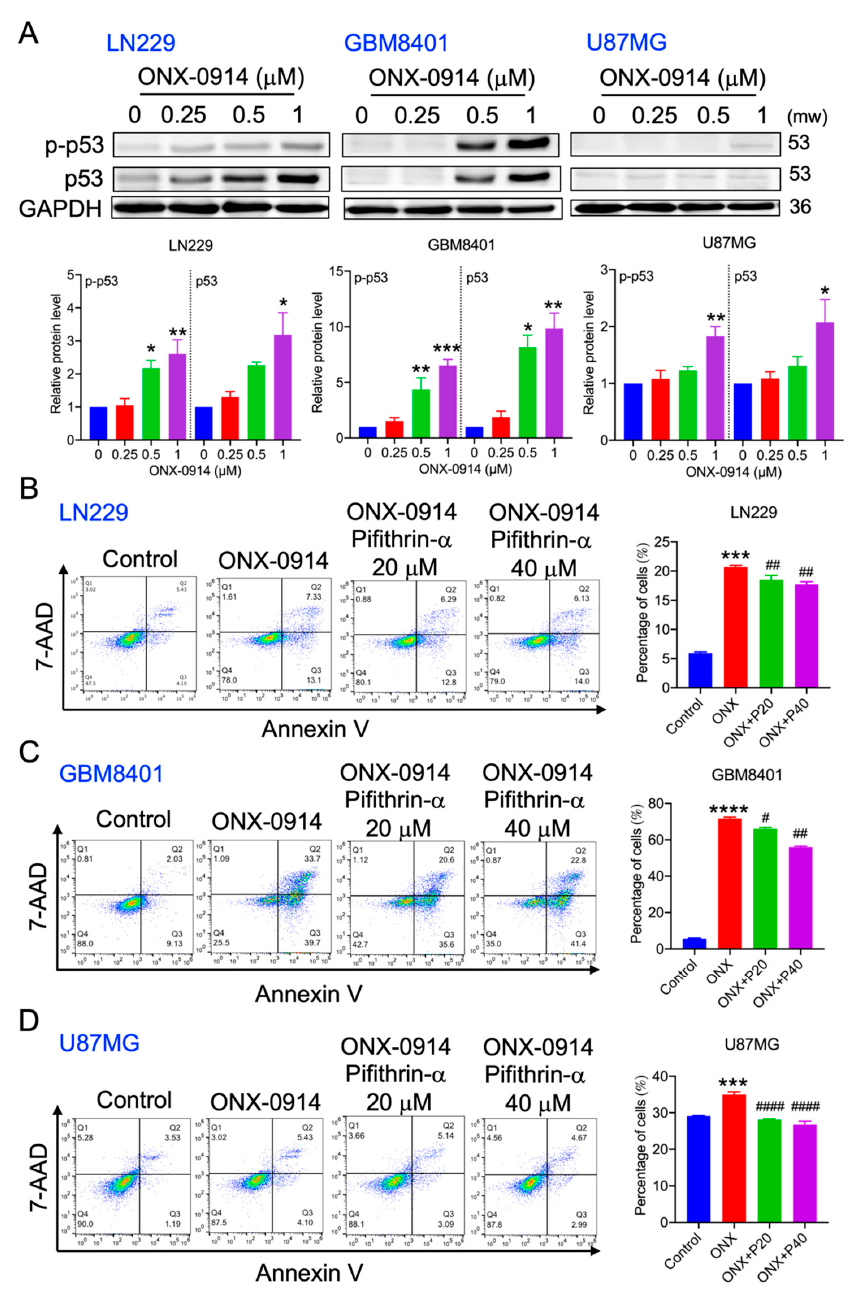
Figure 4. The effect of ONX-0914 treatment on p-p53, p53, and apoptosis. ( A ) Phosphorylated p53 and total protein levels were analyzed by Western blotting. GAPDH was used as a loading control. The lower panels show the quantitative results. Glioblastoma cells were treated with 1 mM ONX-0914 for 24 h after being pretreated with pifithrin for 2 h. Apoptotic cell death was measured using Annexin V-APC/7-AAD staining. The percentage of apoptotic cells is shown in the bar diagram in the right panel. ( B ) LN229, ( C ) GBM8401, and ( D ) U87MG cells. *, p < 0.05; **, p < 0.01; ***, p < 0.001; ****, p < 0.0001 compared to the control group. #, p < 0.05; ##, p < 0.01; ####, p < 0.0001 compared to the ONX-treated